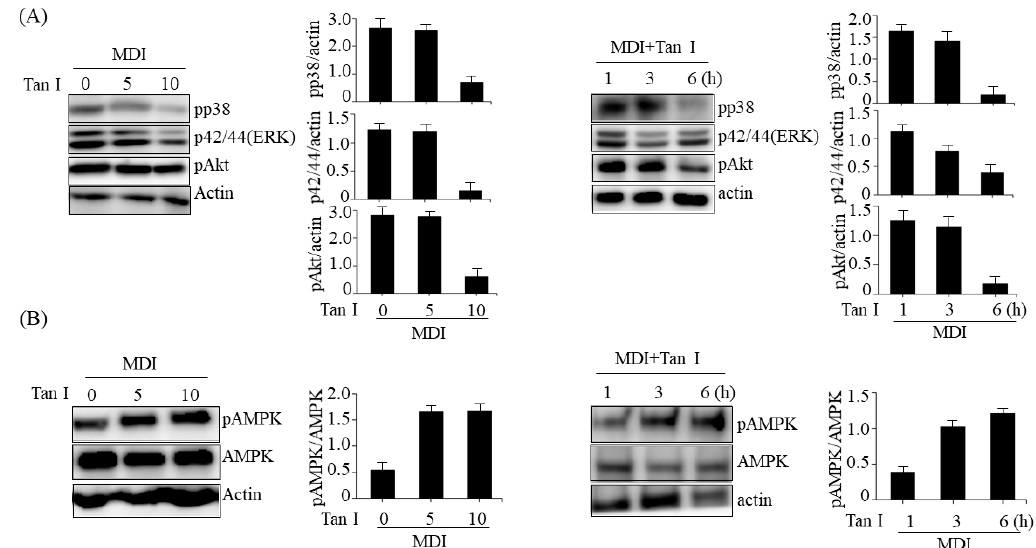
Figure 5. Tan I inhibited p38, extracellular signal-regulated kinase (ERK), PI3 / Akt, and activated AMP-activated protein kinase (AMPK) during early adipogenesis. The 3T3-L1 preadipocytes were di ff erentiated in the MDI with 5 or 10 µ M Tan I for 6 h (left) or di ff erentiated in the MDI with 10 µ M Tan I for indicated times (right). The levels of pp38, p42 / 44 (Erk), pAkt ( A ), and pAMPK ( B ) were analyzed by western blotting. The full length western blots are provided in Supplementary Figures S3–S6. Bar graph represents densitometric analysis of band intensity ratio for pp38 / Actin, p42 / 44 (Erk) / Actin, pAkt / Actin, and pAMPK / AMPK. MDI means di ff erentiation medium.